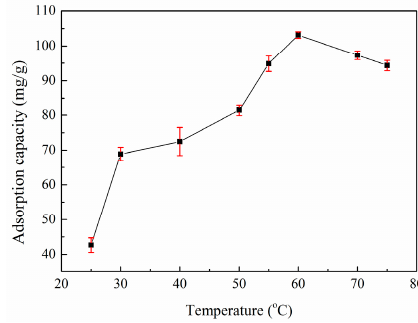
Figure 5. Effect of temperature on the adsorption capacity of XSBLAC for zinc(II). (Adsorption experiments-sample dosage: 0.05 g; initial zinc(II) concentration: 0.015 mol/L; pH range: 5.16; temperature: 25–75 °C; adsorption time: 40 min).